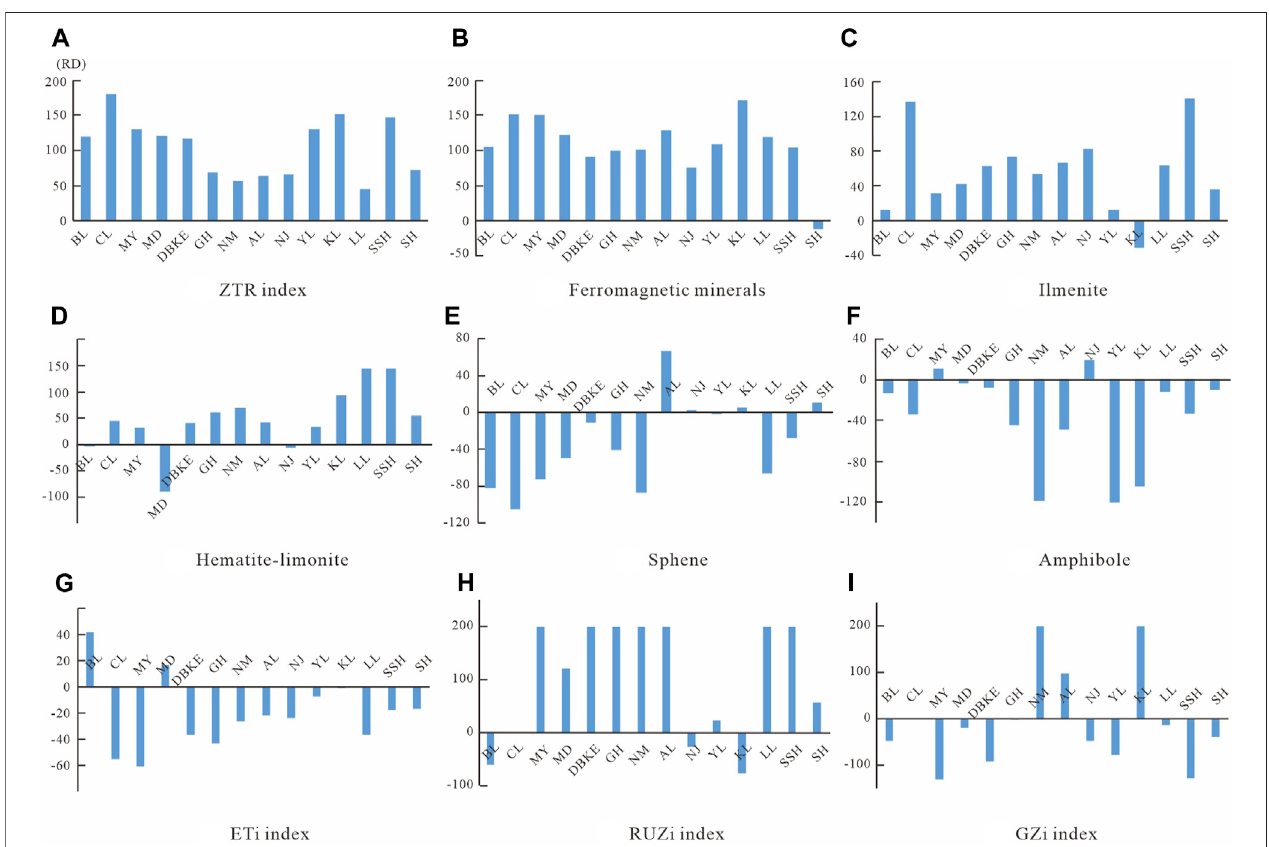
FIGURE7| Therelative deviations (RD)ofheavymineral concentrationsandindexes indifferentparticlesizefractions.TheRDvaluesispositiveitindicates thatthe minerals are enriched in the 63 – 125 µm fraction and vice versa it indicates that the minerals are enriched in the 125 – 250 µm fraction. Abbreviation de fi nitions see Panel 1